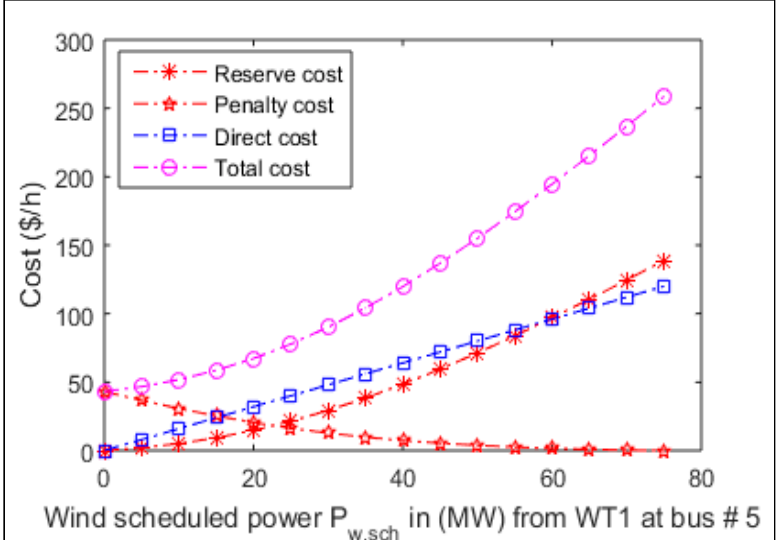
Figure 10. Cost vs. wind schedule power (MW) (bus #5).